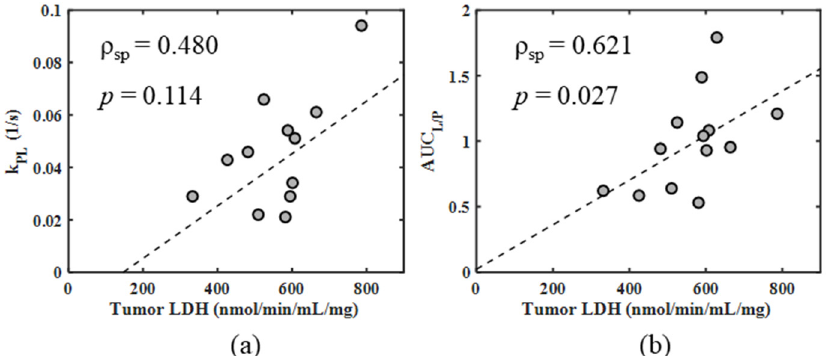
Figure 4. Spearman correlation plots comparing ( a ) k PL and ( b ) AUC L/P with tumor LDH activity. Spearman correlation coefficients ( ρ sp ) and p -values are listed on the plots.